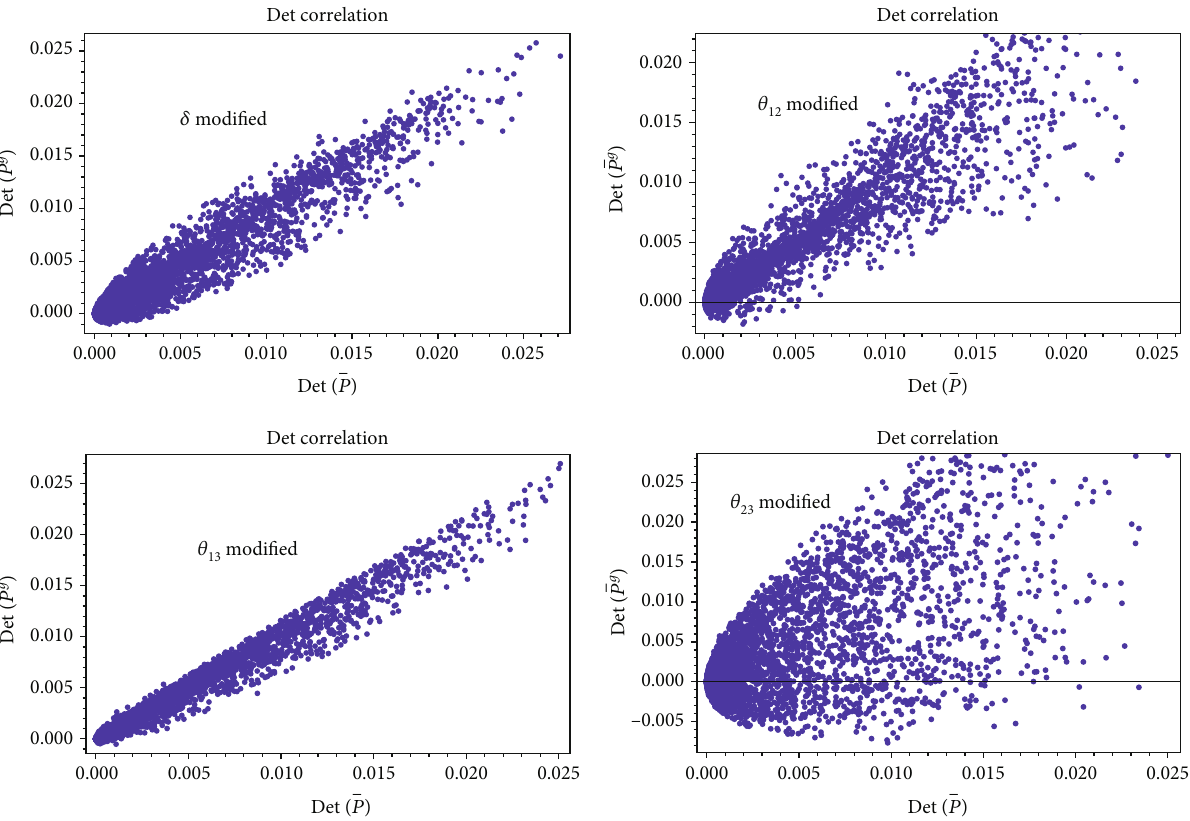
Figure 2: The correlation between Det ð (cid:2) P Þ and Det ð (cid:2) P g Þ . The mixing angles and the CP phase in U are in the ranges of the global fi t data of the normal mass ordering at 3 σ level [4]. The results are similar in the case of the inverted mass ordering. The modi fi ed parameter in U s is randomly taken in the corresponding range in Eqs. (32) – (35).